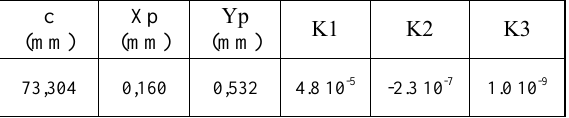
Table 2. Results of calibration at 70 mm.